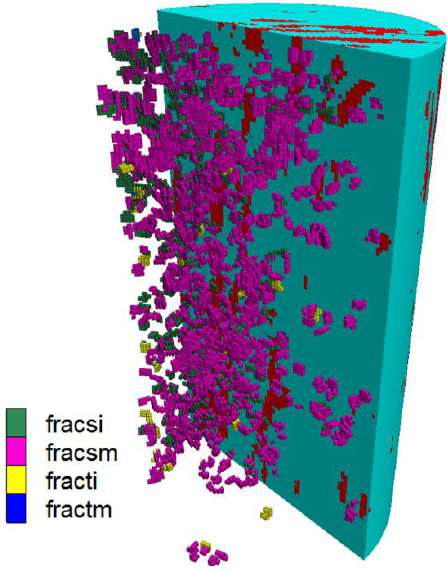
Figure 8. Schematic to illustrate how fractures in principle are represented by zones in the continuum-based model (above: idealized fractures with different orientations, below: representations inside the continuum-based model).